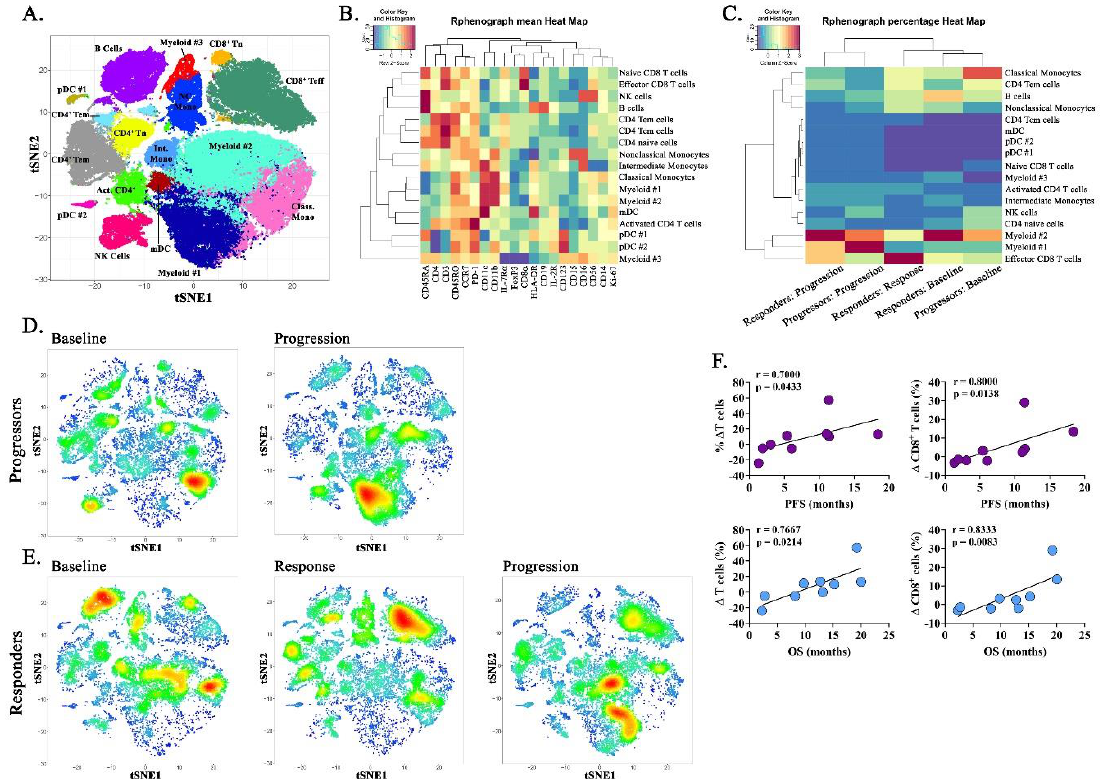
Figure 3. Immunophenotyping of peripheral blood mononucleocytes (PBMCs) identifies unique immune profiles in PD and PR subjects. ( A ) PBMCs from responders ( n = 2) or rapid progressors ( n = 2) were assessed by spectral cytometry (21 color) and analyzed using Rphenograph in Cytofkit for unbiased population discovery. Combined analysis of responding and progressing patient subsets at baseline, at response, and at progression illustrated as a t-SNE plot. ( B ) Heatmap depicting antigen expression of selected phenotypic markers corresponding to cell subsets in Rphenograph t-SNE ( A ). ( C ) Heatmap illustrating the proportion of cell subsets expressed within responders or progressors ( n = 2 per group per timepoint) during baseline, response (after two treatment cycles), and progression. t-SNE density plots illustrating the increased proportion of cell subsets corresponding to Rphenograph for ( D ) rapid progressors and ( E ) responders. ( F ) Spearman correlations among all evaluable subjects between the change in percentage of total CD3 + T cells or CD3 + CD8 + T cells with progression-free survival or overall survival, as indicated.